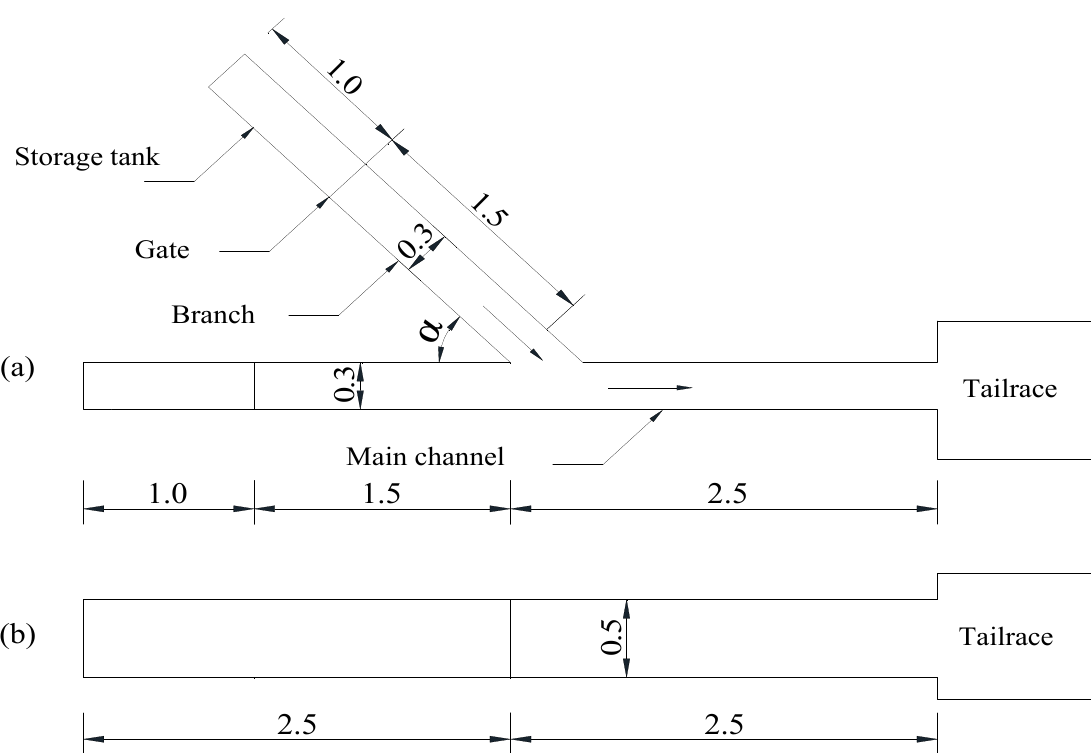
Figure 3. Sketch of the test channel, ( a ) plan view; ( b ) elevation (unit: m).